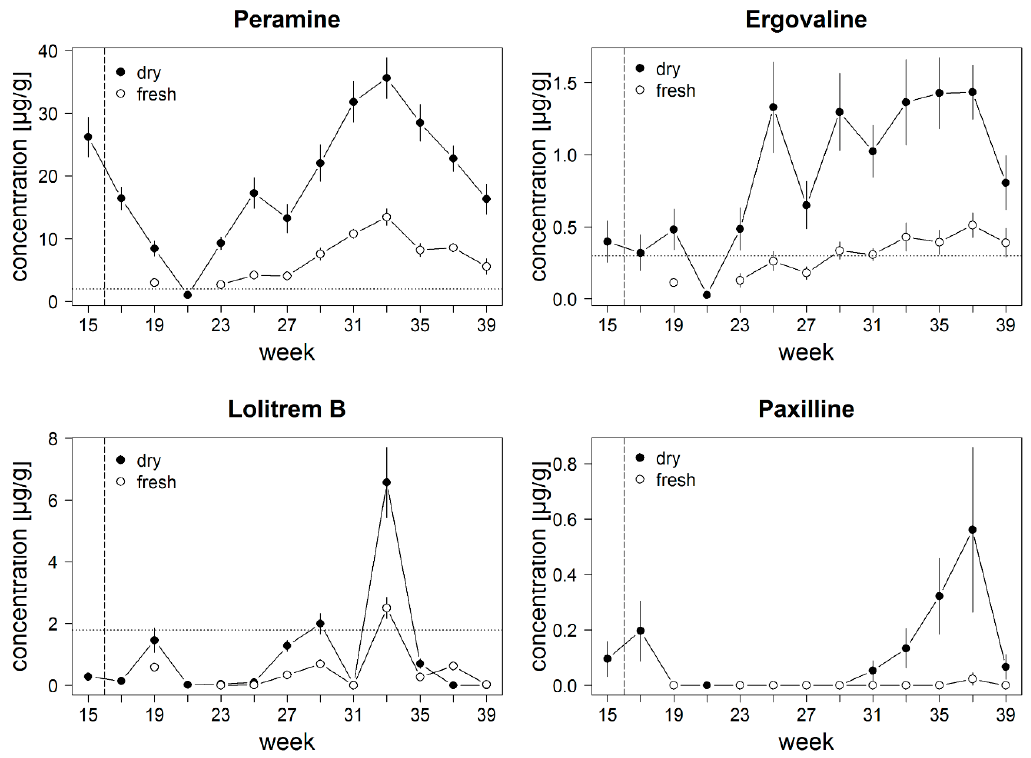
Figure 2. Alkaloid concentrations in [µg/g] (mean ± SE) in L. perenne plants infected with Epichloë festucae var. lolii during several weeks (calendar weeks) in a common garden experiment analyzed with dry (filled circles) and fresh (empty circles) plant weight. Plants were sampled every two weeks from the beginning of April until the end of September. The first sampling (calendar week 15) was performed in the greenhouse, afterwards the plants were placed outside in a common garden (marked with a vertical dashed line). Toxicity thresholds based on dry weight are marked with a horizontal dotted line.